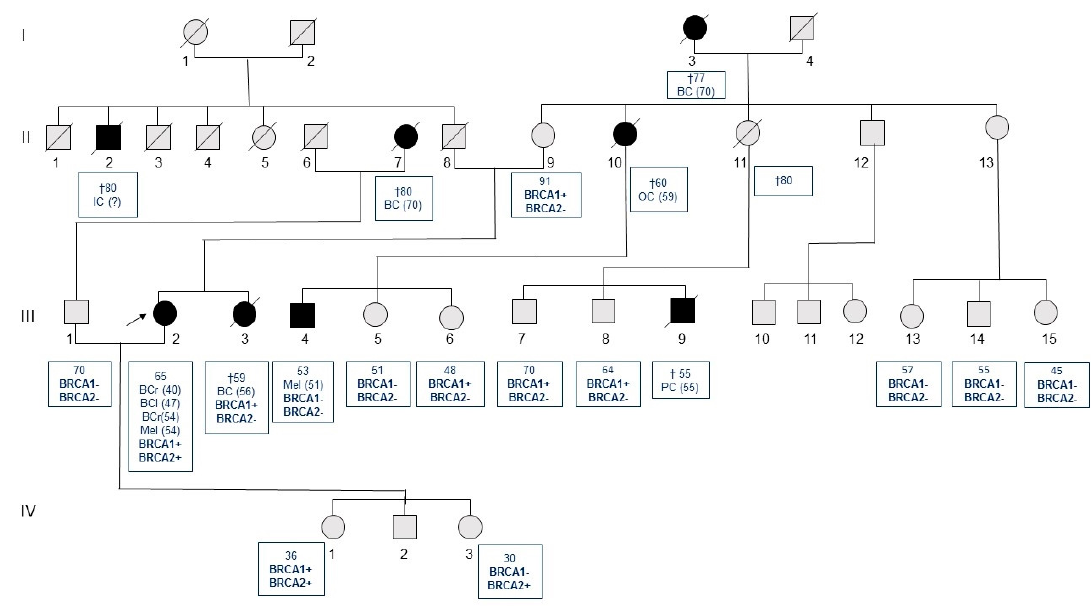
Figure 2. Pedigrees of the family with double hetyerozigosity for BRCA1 c.1687C>T and BRCA2 c.9976A>T variants. BC: breast cancer; BCr: breast cancer right; BCl: breast cancer left; OC: ovarian cancer; Mel: melanoma; PC: pancreatic cancer; IC: intestinal cancer. Black circles and squares: cancer patients; gray circles and squares: subjects without cancer; diagonal lines: dead subjects; †: age of death; arrow: proband.